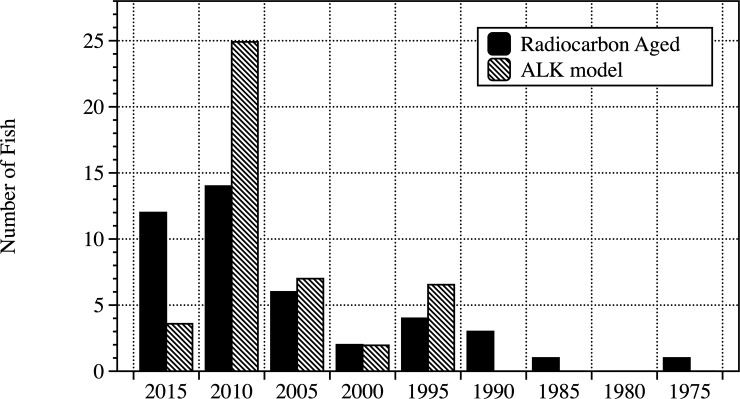
Comparison of the actual age frequency of lungfish with those derived from the ALK.Results from fish <850 mm in length from the Burnett River derived from radiocarbon aging and that derived using the ALK of the sub–sampled population.